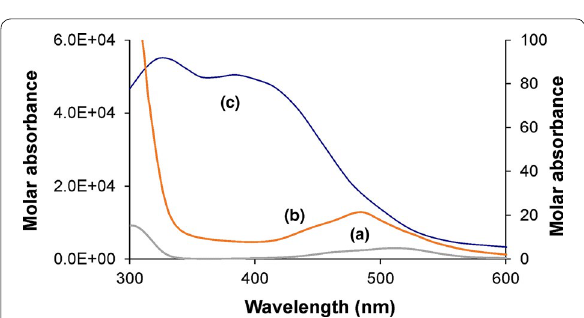
Fig. 6 UV/Vis spectra in the Co(II)–amac–Himid system at tempera- ture ~0 °C, where amac -α-histidine. Right Y-axis: molar absorption = l coefficients of (a) Co(II) and (b) “active” heteroligand complex CoL 2 L ′ , where L amac, L ′ Himid; left Y-axis: (c) molar absorption coefficients of the dioxygen